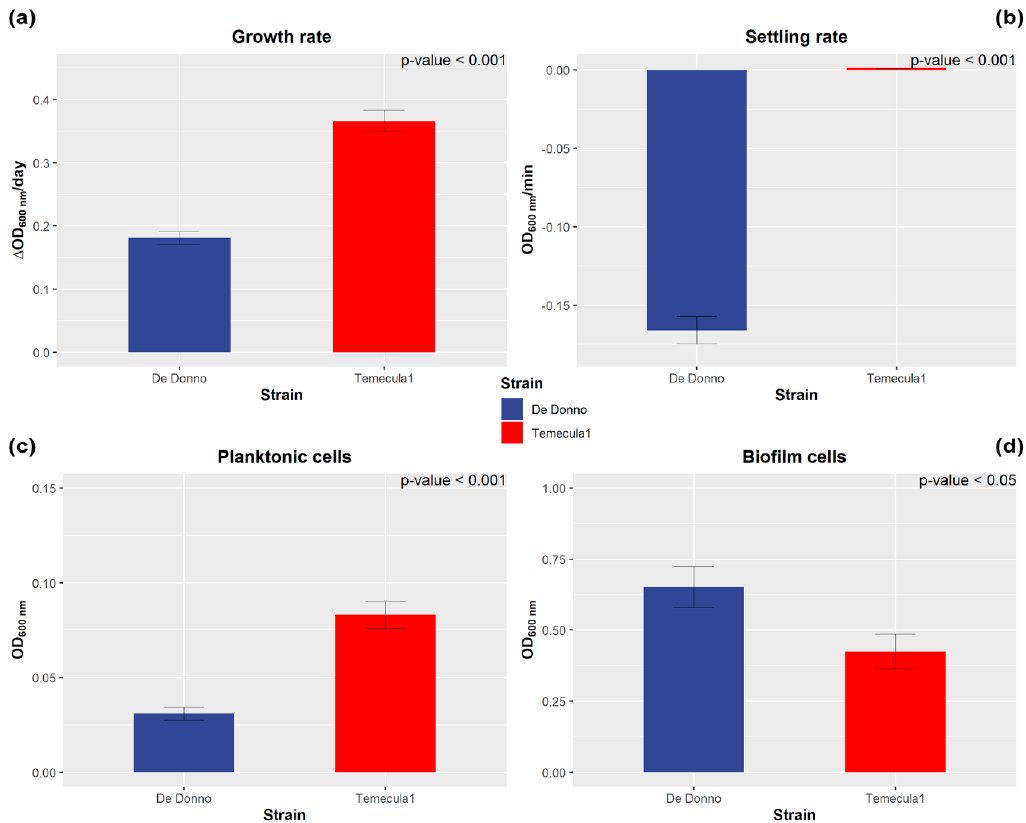
Figure 2. Comparison of biological traits between X. fastidiosa strains Temecula1 and De Donno. Both strains were grown in the PD3 medium. The growth rate ( a ) was calculated from the growth curve at the exponential phase (1–4 dpi). Settling rate ( b ) was assessed by suspending bacterial culture in a 1 mL-cuvette and continuously measuring optical density for 3 min. Planktonic growth ( c ) was assessed by measuring optical density (OD) at the end of the growth-curve experiment (7 dpi). Biofilm formation ( d ) was assessed by measuring OD, using crystal violet staining in the 96-well plates, at the end of the growth-curve experiment (7 dpi). Experiments ( a – d ) were repeated independently three times. For 96-well plate assays ( a , c , d ) 6 wells per plate and 3 plates per experiment were used for each strain. Error bars indicate the standard error of the mean. OD was measured at 600 nm wavelength. p -values show statistically significant di ff erences between strains, as assessed by a Student’s t -test at the 5% significance level.